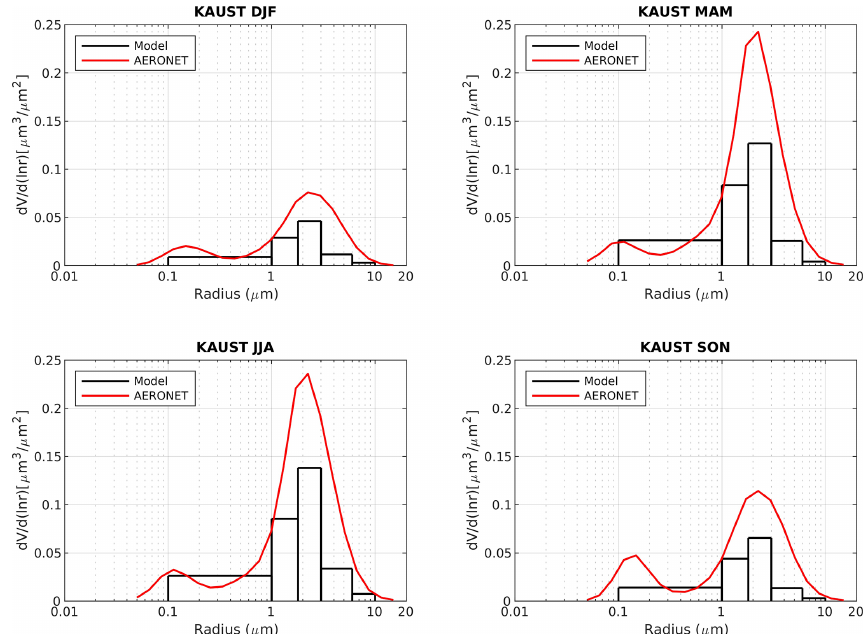
Figure 6. Column-integrated volume size distributions and concentrations of only dust from the model, plotted against AERONET aerosol volume concentrations at